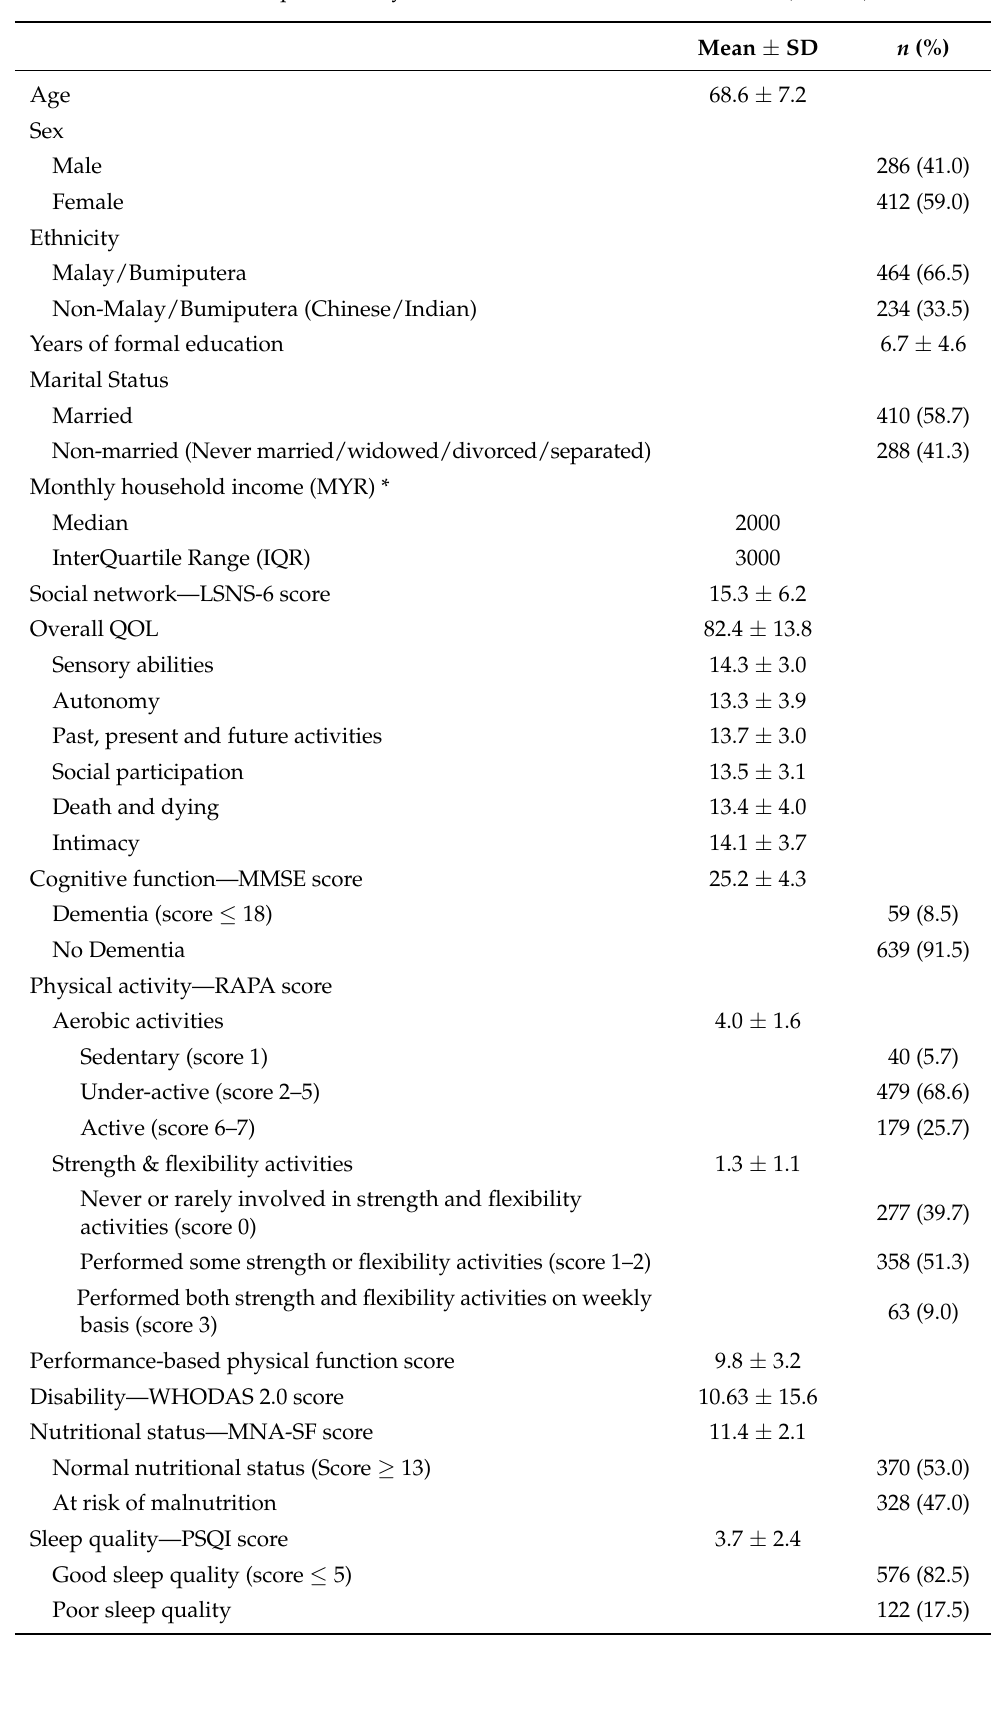
Table 1. Distribution of respondents by QOL, social, and health determinants ( n =